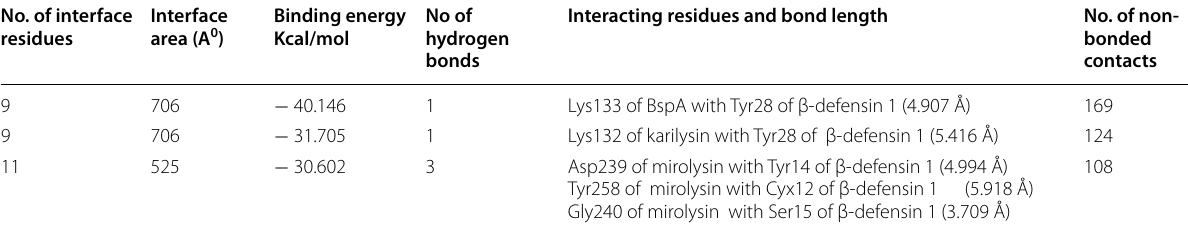
Table 8 Interaction results of β-defensin 1 with BspA, karilysin, and mirolysin of T. forsythia No. of interface